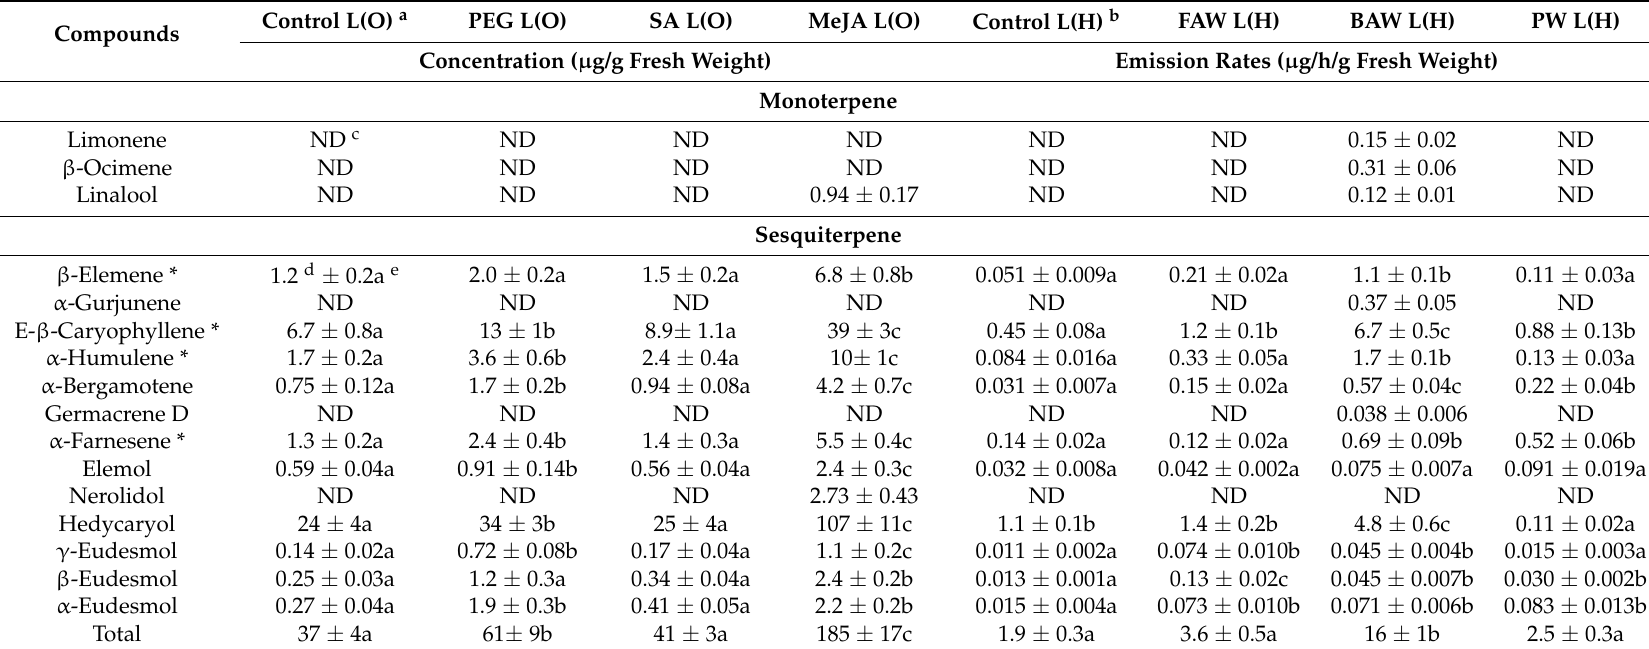
Table 1. The composition of terpenoids in C. iria leaves induced by biotic and abiotic